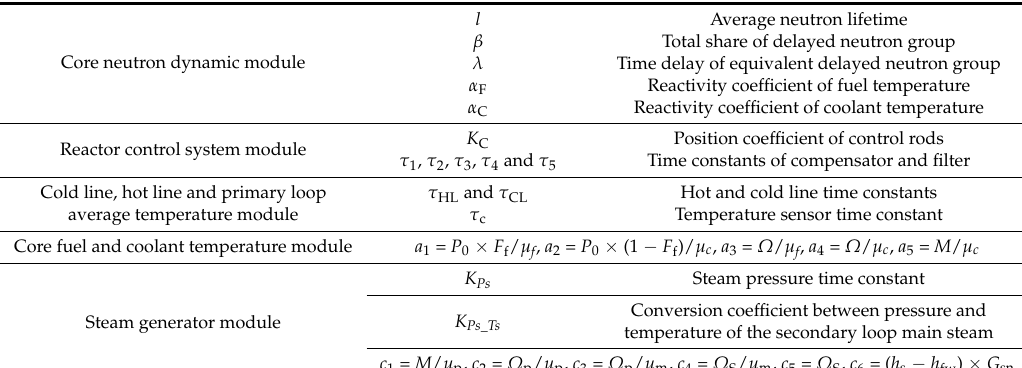
Table 2. Model parameter values.